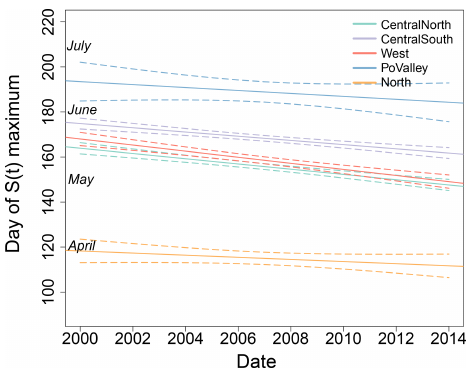
Figure 10. Linear trends of the S DoMax for the daily mean S(t) clusters (dashed lines show the 90% confidence